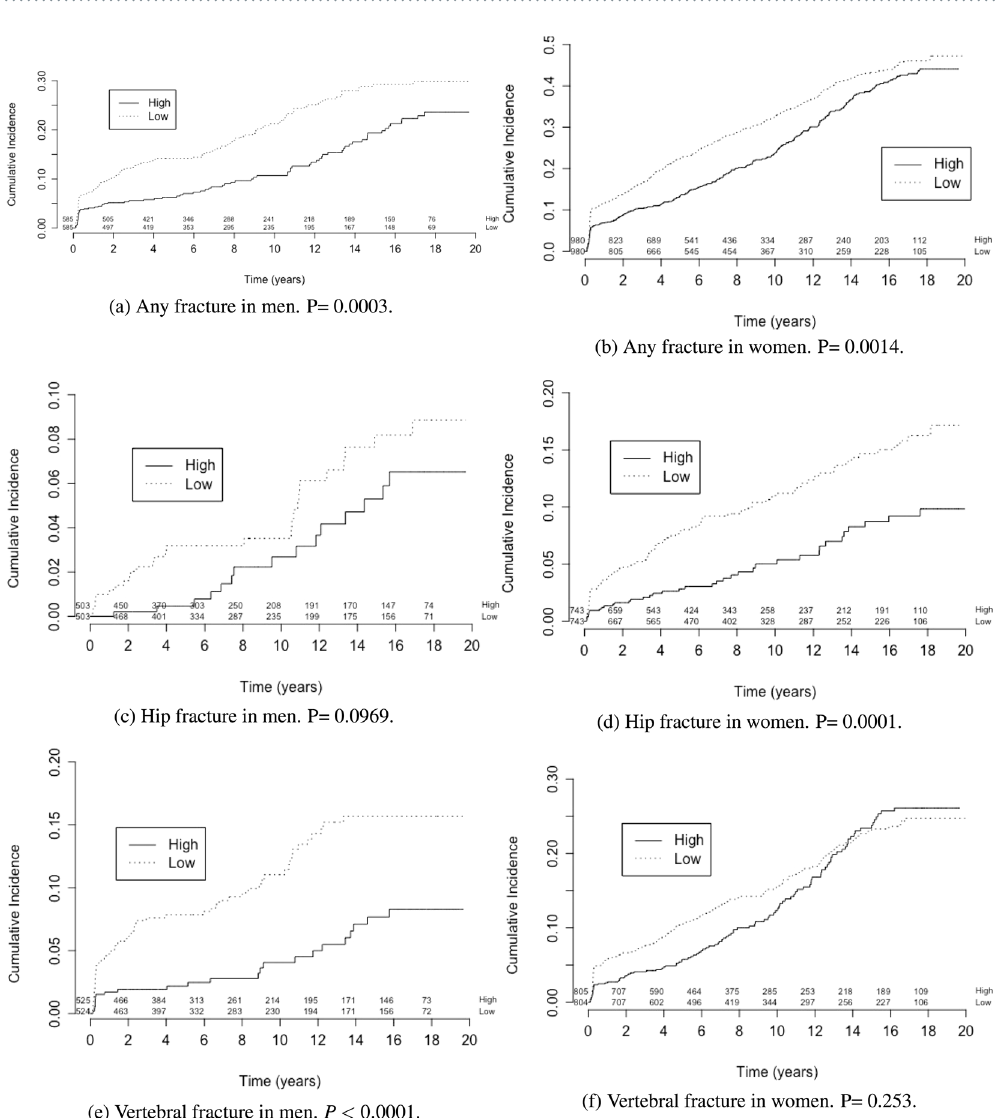
Figure 3. Cumulative Incidence over time (years) in men and women. P: P-value reported in each subplot is for the difference between survival curve by Chisquare test. ( a ) Any fracture in men. P = 0.0003. ( b ) Any fracture in women. P = 0.0014. ( c ) Hip fracture in men. P = 0.0969. ( d ) Hip fracture in women. P = 0.0001. (e ) Vertebral fracture in men. P < 0.0001. ( f ) Vertebral fracture in women. P = 0.253.